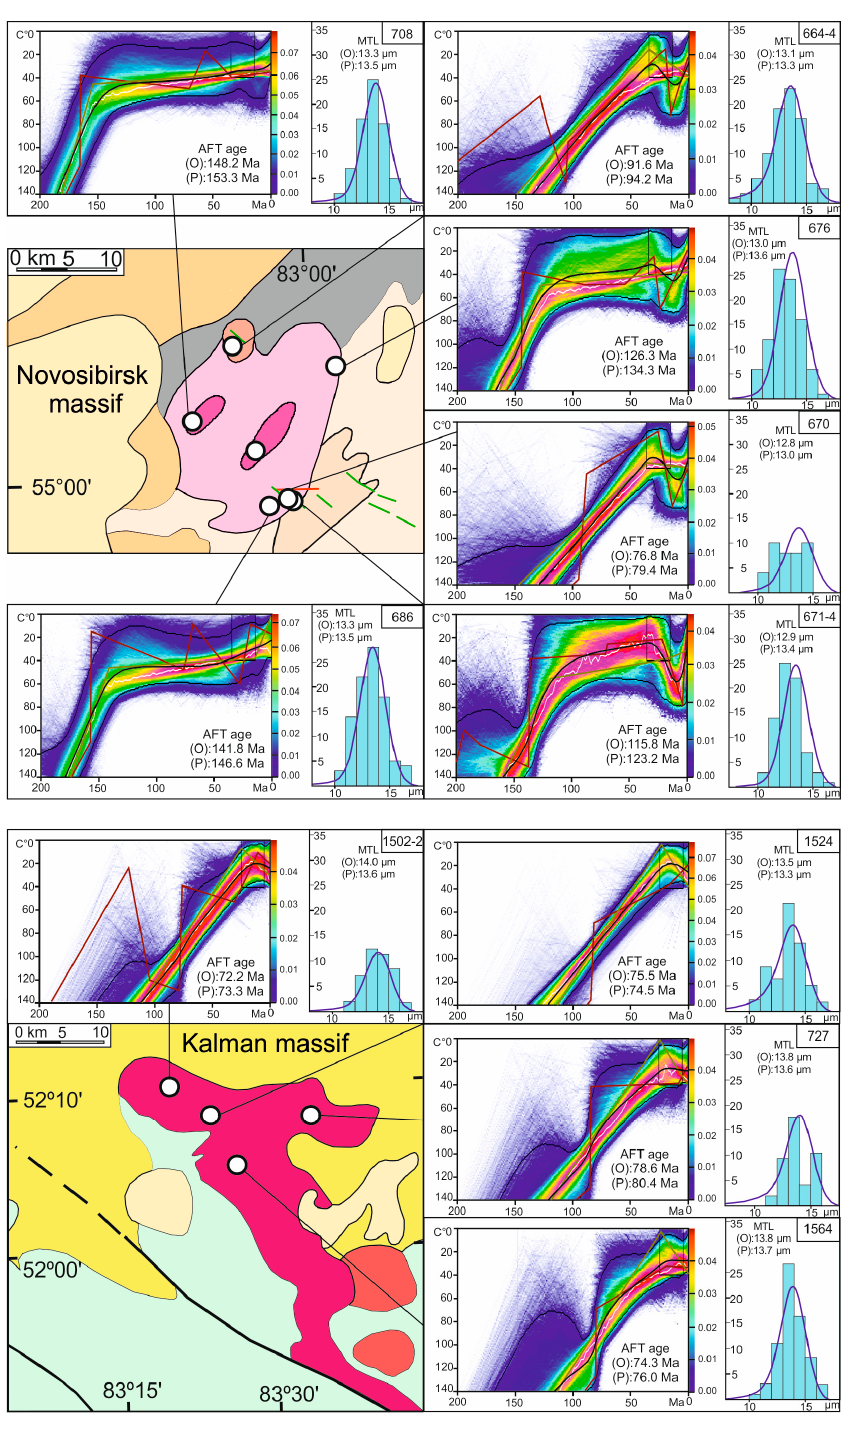
Figure 3. AFT thermal history modeling results produced by the QTQt software [44] and track length distributions for individual samples from the Ob, Novosibirsk, and Kalman massifs. Thermal history models are presented in a fixed time-temperature interval of 0 – 140 °C and 200 – 0 Ma. The color scale indicates high probability for red and yellow, but low probabilities for blue colors. The central black curve and its surrounding envelope display the expected time-temperature (t-T) model and the 95% probability range interval. The red line indicates the maximum likelihood model while the khaki line shows the maximum posterior model. For each sample observed (O) and predicted (P) data for AFT ages, the mean track length (MTL) and the fit (blue line) of the track length distribution are displayed. The legend for the geological maps is the same as shown in Figure 1.